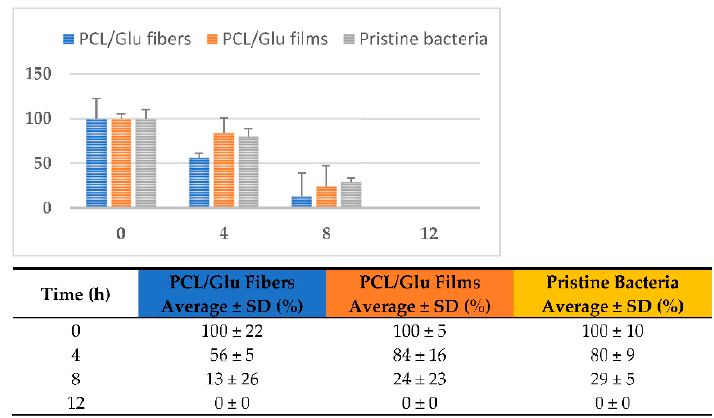
Figure 8. Percentage (%) of chromium uptake by P. aeruginosa in water bioremediation assay.